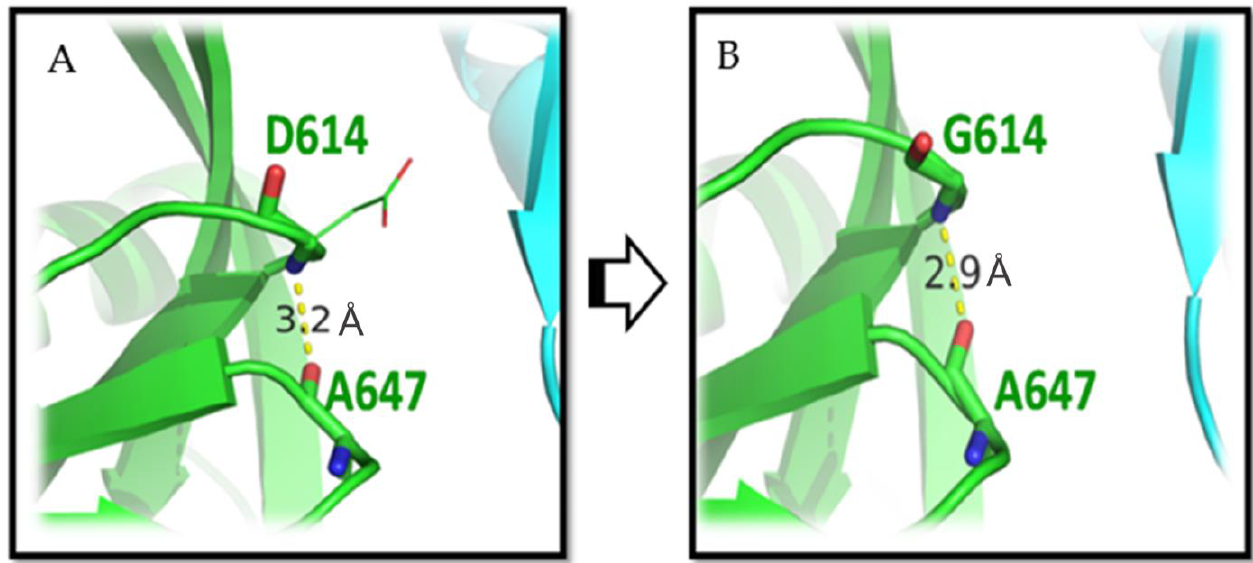
Figure 2. The D614G mutation in the SARS-CoV-2 spike protein. ( A ) D614 in the wild-type spike glycoprotein, and ( B ) G614 the mutated form of D614. The three-dimensional structure of the spike glycoprotein is represented colored by the chain. The yellow dotted line represents the hydrogen bond formation between residues 614 and 647, which shortens when aspartic acid mutates to glycine. The length between residues is shown in units of Angstrom (Å).